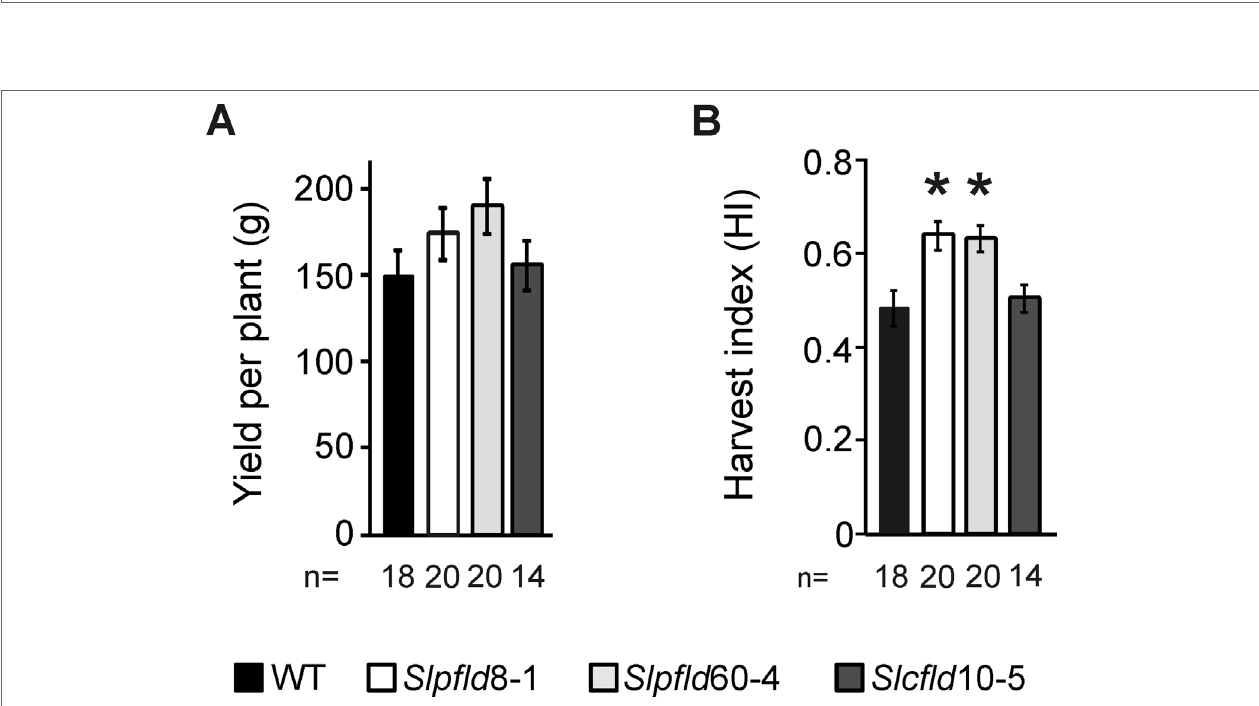
FIgURE 6 | Chloroplast flavodoxin expression increased fruit harvest index. (A) Yield was estimated as the sum of all fruit harvested up to 120 days post- germination regardless of the ripening stage. (B) Harvest index was calculated as described in Materials and Methods . Data reported are means ± SEM of n biological replicates, as shown below each line. Statistically significant differences are indicated by asterisks and were determined using one-way ANOVA and Tukey's multiple comparison test ( P < 0.05).